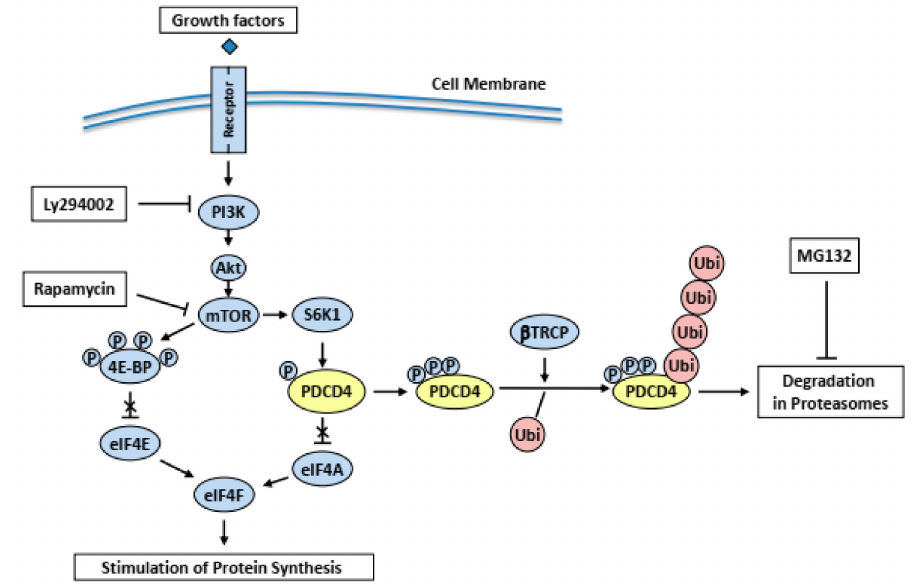
Figure 4. Pathways of EGF mediated protein synthesis and PDCD4 degradation. EGF stimulates the phosphorylation of the eIF4E inhibitor 4E-BP via activation of PI3K-Akt-mTOR pathway and thereby activating protein synthesis. On the other hand, mTOR-activated S6K1 phosphorylates PDCD4-protein. The phosphorylated protein is ubiquitinated by SCF β TRCP ( β TRCP) ubiquitin (Ubi) ligase and degraded in proteasomes stimulating protein